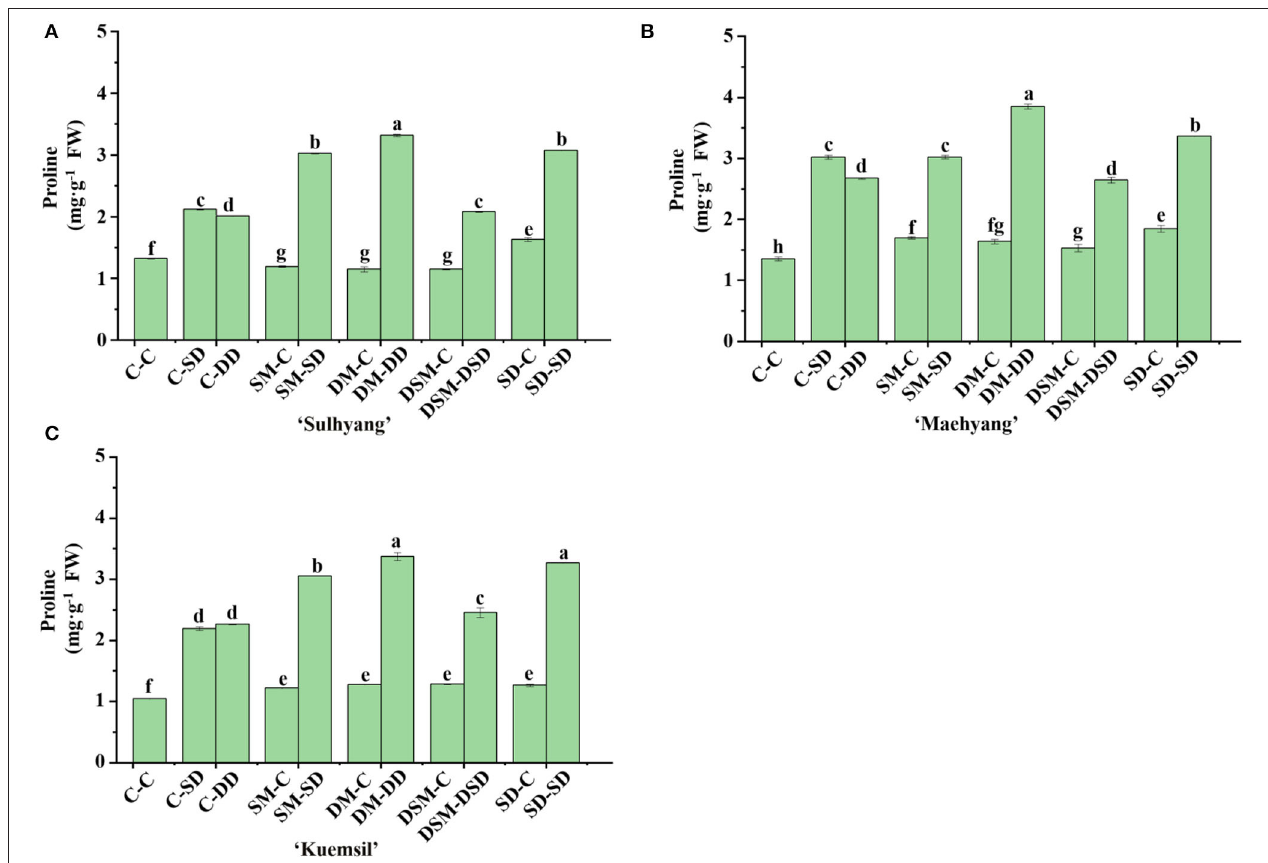
FIGURE 15 | Proline content in leaves of strawberry transplants (A) “Sulhyang”; (B) “Maehyang”; and (C) “Kuemsil” as affected by the Si treatment after subjection to 43 ◦ C for 7 days. Lowercase letters indicate significant differences calculated by the Duncan’s multiple range test at p ≤ 0.05. See Figure 1 for descriptions of treatment